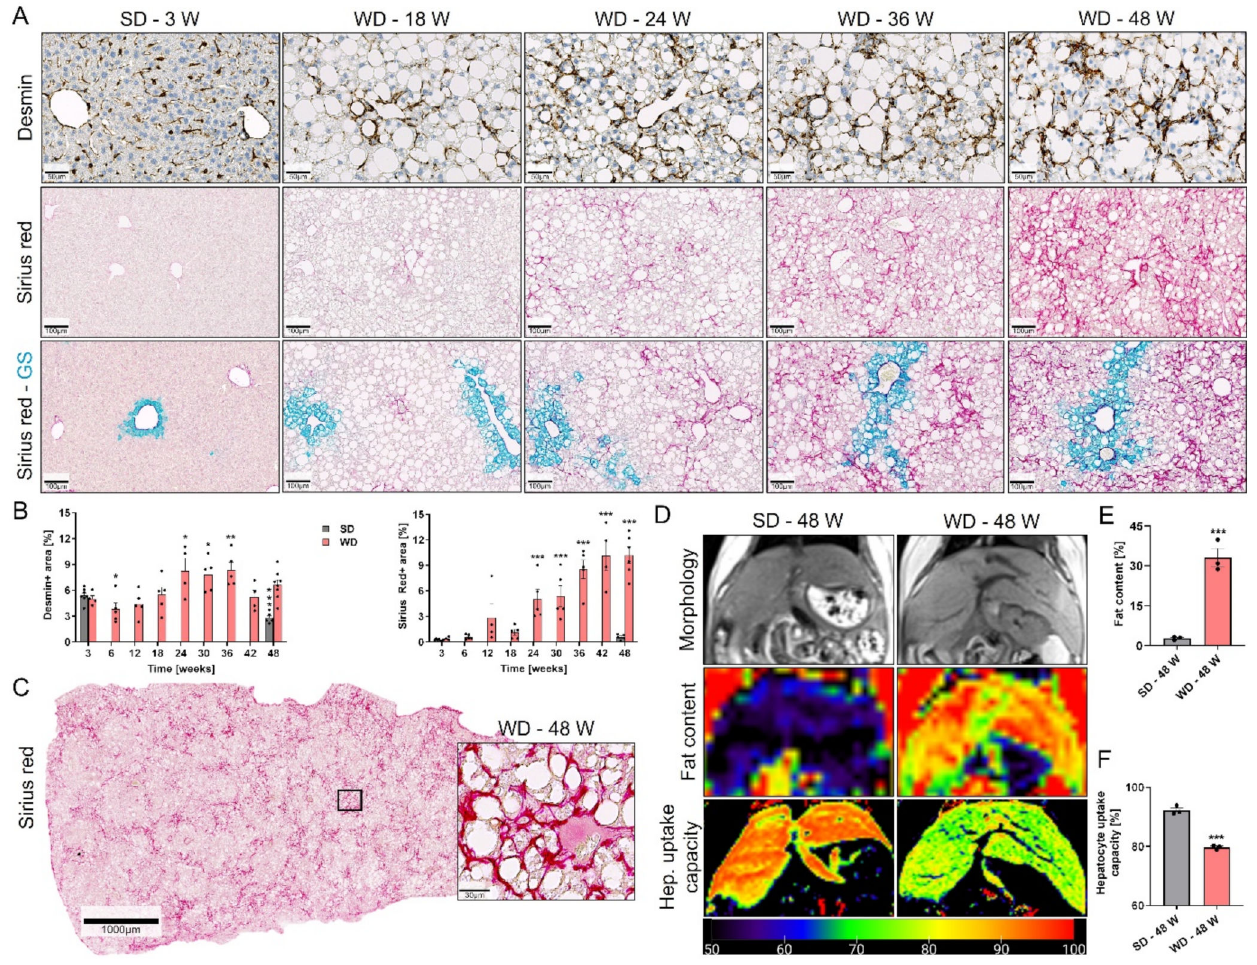
Figure 6. Fibrosis progression after Western diet feeding. ( A ) Staining of SD- or WD-fed mouse liver sections with desmin (scale bars: 50 µ m), Sirius red, and GS (scale bars: 100 µ m). Of note, GS expression expanded at week 36. In addition, central veins became localized to delicate fibrotic septa thus forming initial portal-central bridges indicating architectural distortion, which progressed until week 48. ( B ) Quantification of the desmin and Sirius red positive areas. Data represent mean and standard errors of 4–8 mice per time point. *: p < 0.05; **: p < 0.01; ***: p < 0.001 compared to SD week 3, Sidak’s multiple comparisons test; data of individual mice are illustrated by dots; SD: standard diet; WD: Western diet. ( C ) Whole slide scan (scale bar: 1000 µ m) of a Sirius red-stained liver section from 48-week WD-fed mouse, with enlarged inset (scale bar: 30 µ m) to show detail. ( D ) MRI analysis of the morphology, fat content, and hepatocyte uptake capacity after 48 weeks of SD and WD. ( E , F ) Quantification of the MRI signals representing fat content and hepatocyte uptake capacity. Data in E and F were acquired from three mice per time point; ***: p < 0.001 compared to SD, unpaired t